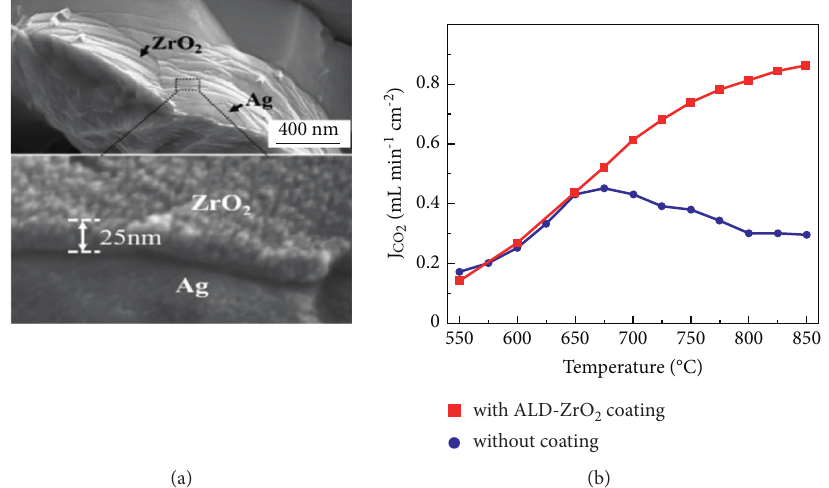
Figure 18: (a) SEM image of ALD deposited ZrO coating